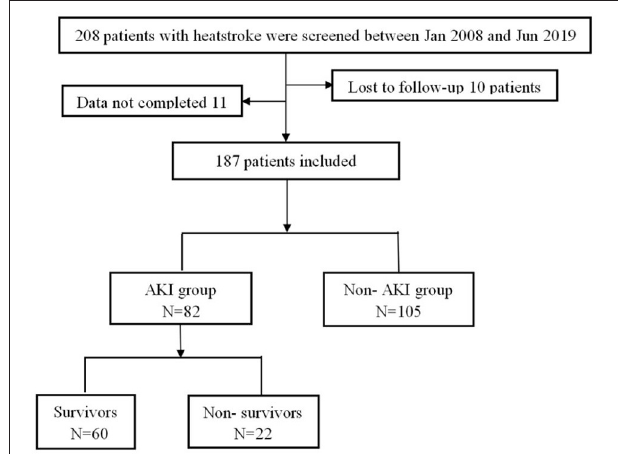
FIGURE 1 | Flow chart of all excluded and included